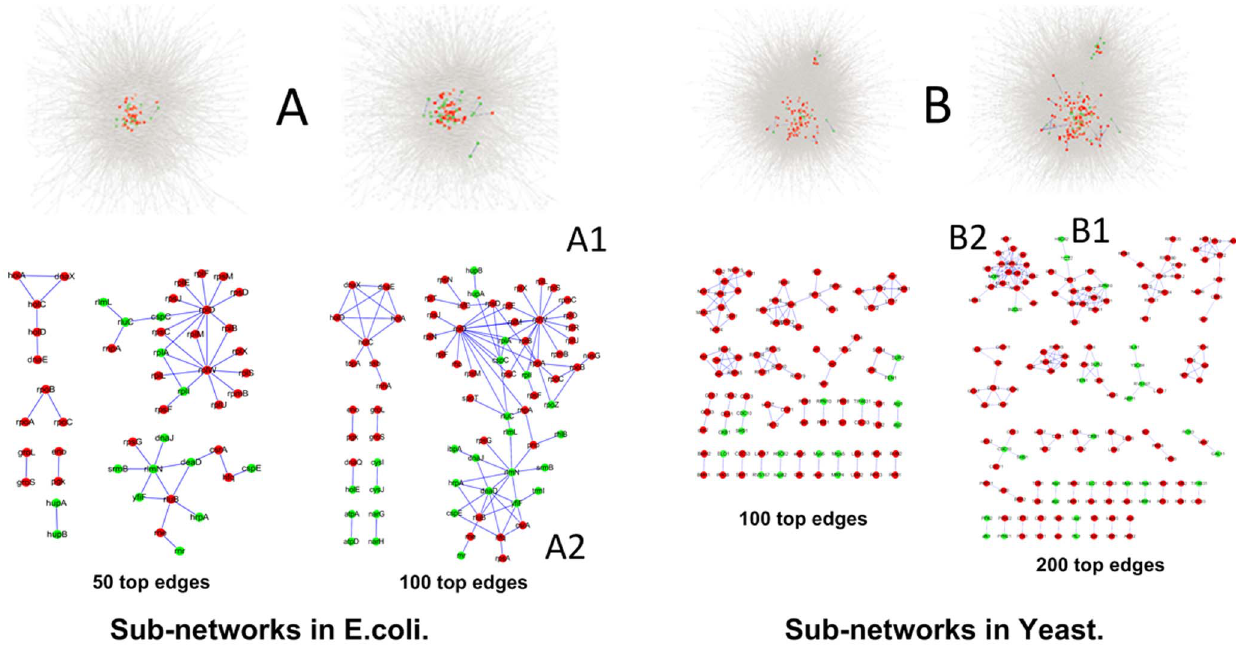
Figure 4. Sub-networks in (A) E.coli and (B) Yeast PPI network formed by top edges. The red nodes are essential proteins and the green ones are non-essential proteins.